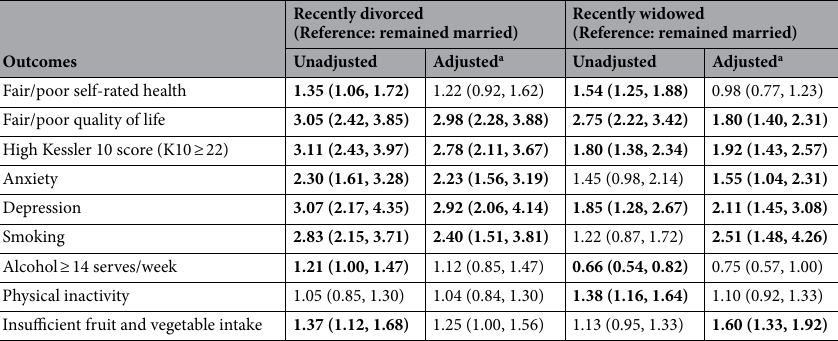
Table 3. Odds ratios for the associations of marital disruption which occurred between T1 (2006–2009) and T2 (2010) with health-related outcomes at T2 (n = 33,184). T1: baseline data collection (2006–09), T2: first follow-up: 2010. Boldface indicates statistical significance at p < 0.05. Remained married: married at T1 and T2; Recently divorced: married at T1 and divorced/separated at T2; Recently widowed: married at T1 and widowed at T2. a Adjusted for the outcome value at T1, age, sex, educational attainment, residential location (major cities vs regional/remote), country of birth (Australia vs overseas), and follow-up time between T1 and T2.